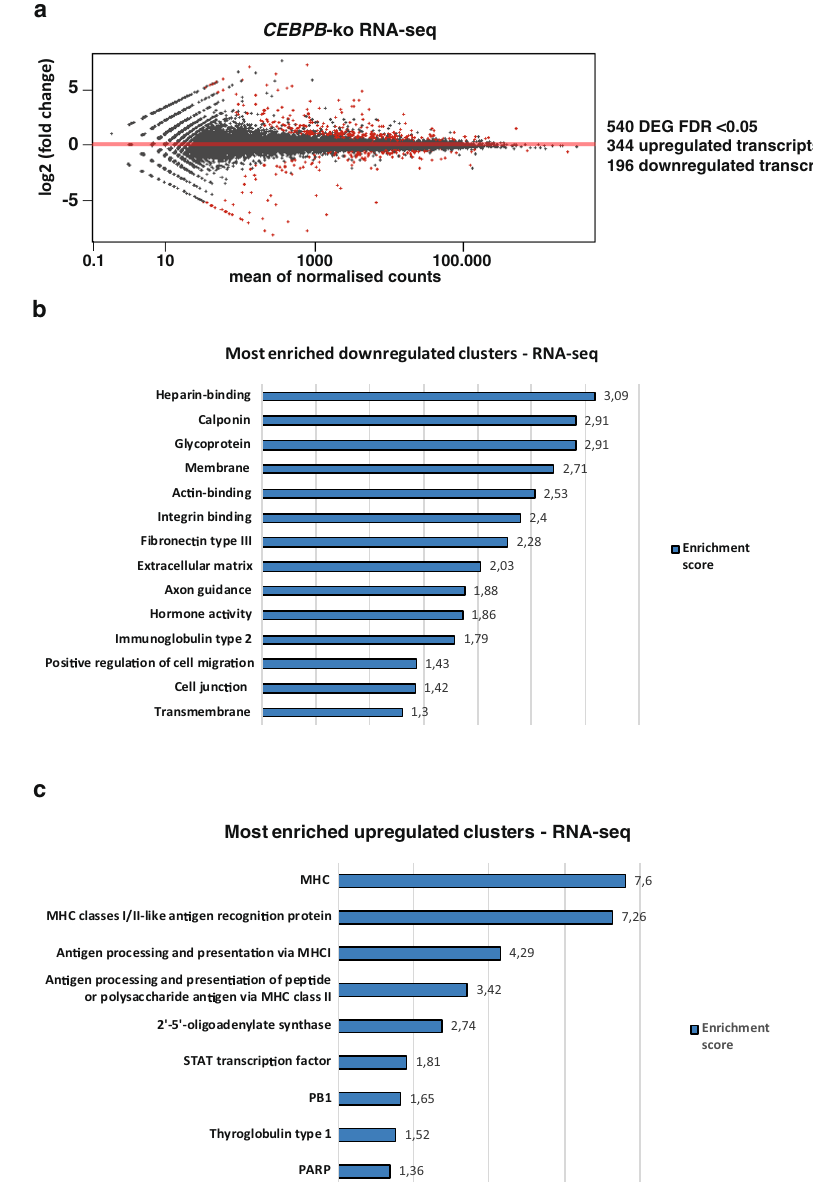
Fig. 2 Transcriptomics and functional clustering analysis of BT-20 CEBPB -ko vs BT-20 wt cells. a Differentially expressed genes (DEG) in BT- 20 CEBPB -ko cells vs BT-20 wt cells with an FDR < 0.05. b Most downregulated clusters (DAVID) of mRNAs downregulated in CEBPB -ko cells (medium stringency). c Most upregulated clusters (DAVID) of mRNAs upregulated in CEBPB- ko cells (high